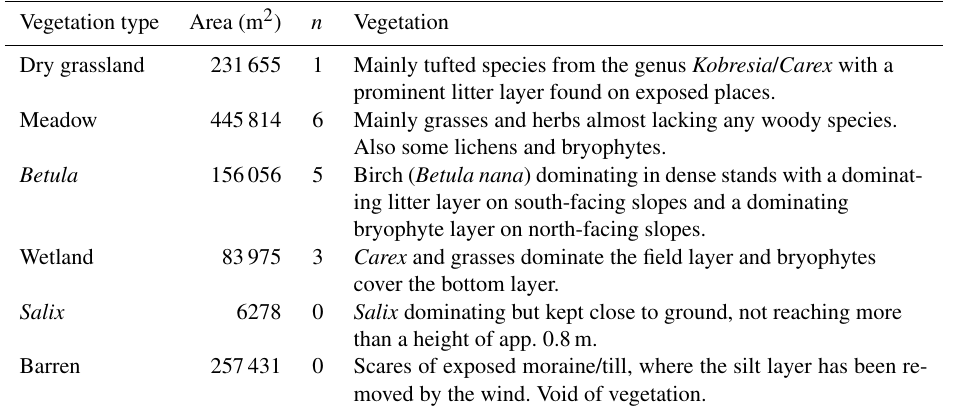
Table 1. The five main vegetation types and the vegetation-free barren land within the catchment area and their respective areal coverage. The number of investigated plots ( n ) in August 2011 and short characterisations of the vegetation types are also given. Vegetation type Area (m 2 ) n Vegetation Dry grassland 231655 1 Mainly tufted species from the genus Kobresia / Carex with a prominent litter layer found on exposed places. Meadow 445814 6 Mainly grasses and herbs almost lacking any woody species. Also some lichens and bryophytes. Betula 156056 5 Birch ( Betula nana ) dominating in dense stands with a dominat- ing litter layer on south-facing slopes and a dominating bryophyte layer on north-facing slopes. Wetland 83975 3 Carex and grasses dominate the field layer and bryophytes cover the bottom layer. Salix 6278 0 Salix dominating but kept close to ground, not reaching more than a height of app. 0.8m. Barren 257431 0 Scares of exposed moraine/till, where the silt layer has been re- moved by the wind. Void of